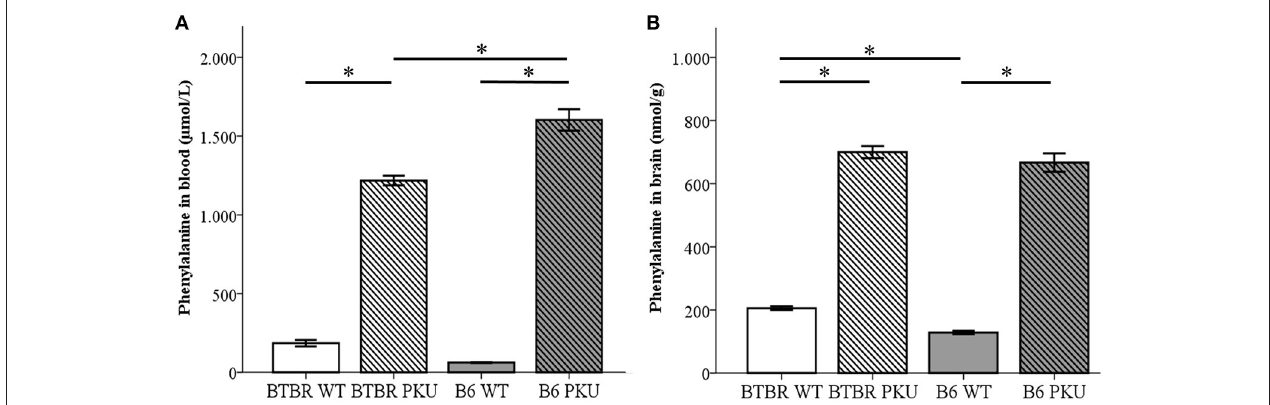
FIGURE 2 | Phenylalanine concentrations in blood and brain. (A) Phenylalanine concentrations in blood ( µ mol/L) ( n = 4–6), and (B) phenylalanine content in the brain (nmol/g) ( n = 5–6) of BTBR and C57Bl/6 (B6) wild-type (WT) and phenylketonuria (PKU) mice. * p ≤ 0.05; mean ± SEM.